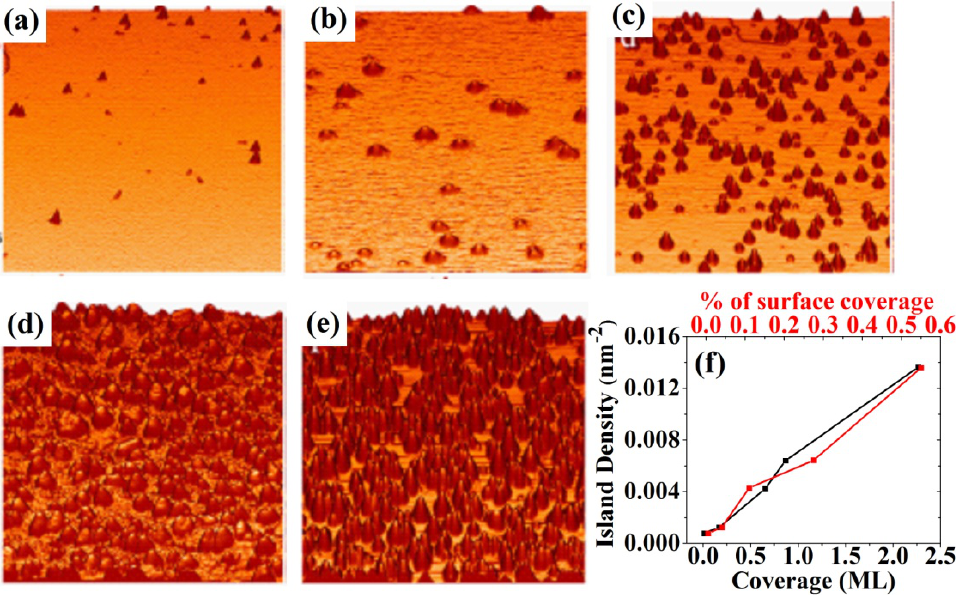
Figure 5. ( a – e ) Corresponding images at different θ . ( a ) 0.003 ML; ( b ) 0.16 ML; ( c ) 0.65 ML; ( d ) 0.87 ML; ( e ) 2.3 ML. Small islands in each image show the new islands that have just nucleated. All images are 200 × 200 nm 2 except (b) which is 150 × 150 nm 2 ; ( f ) Island density n vs. θ for Fe grown on graphene at room temperature showing a monotonic dependence on θ up to at least 55% surface coverage ( θ = 2.3 ML).